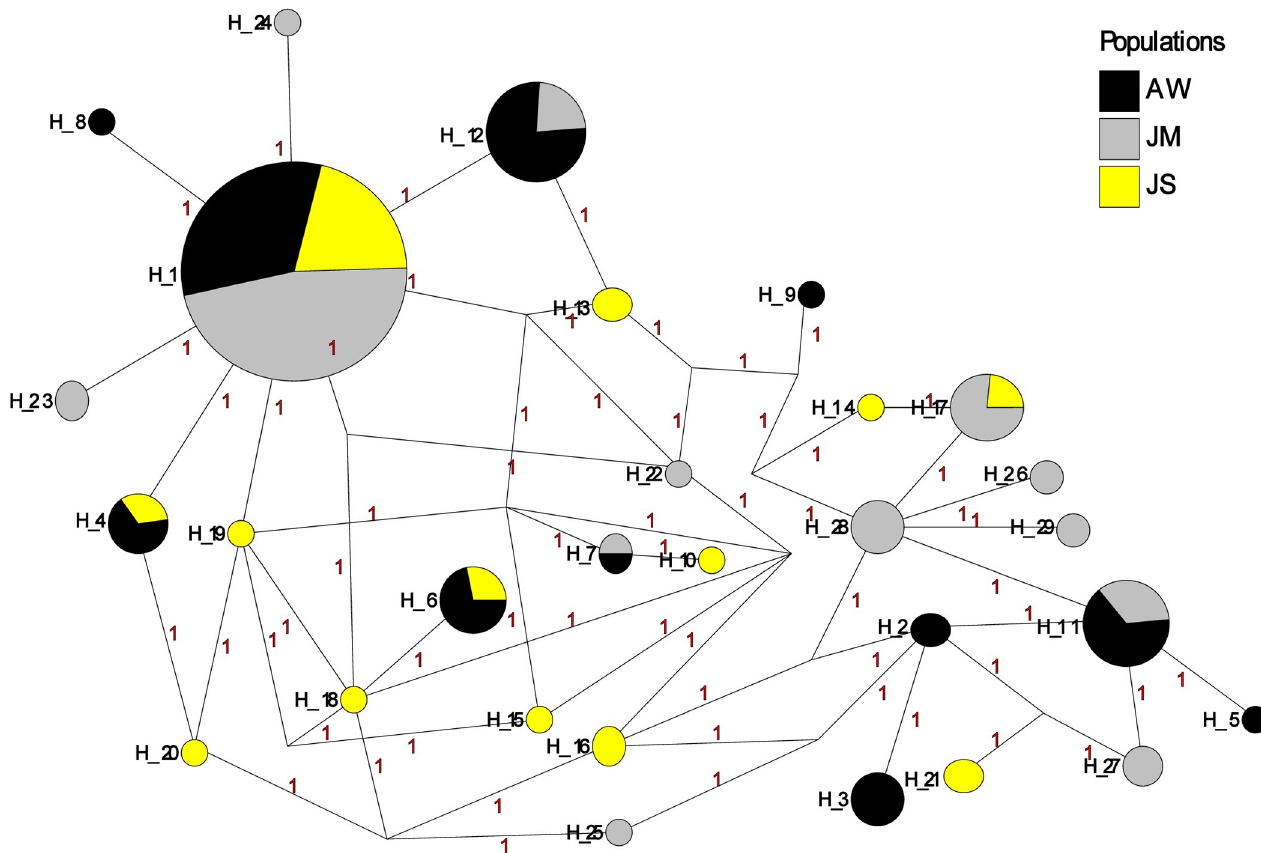
Fig 3. Median-joining network for PpSP12 P . papatasi haplotypes. Circle size and circle color indicates frequency and geographical location of haplotypes, respectively. Haplotype numbers are written next to the corresponding circle H_XX. Red numbers between haplotypes indicate number of mutations between